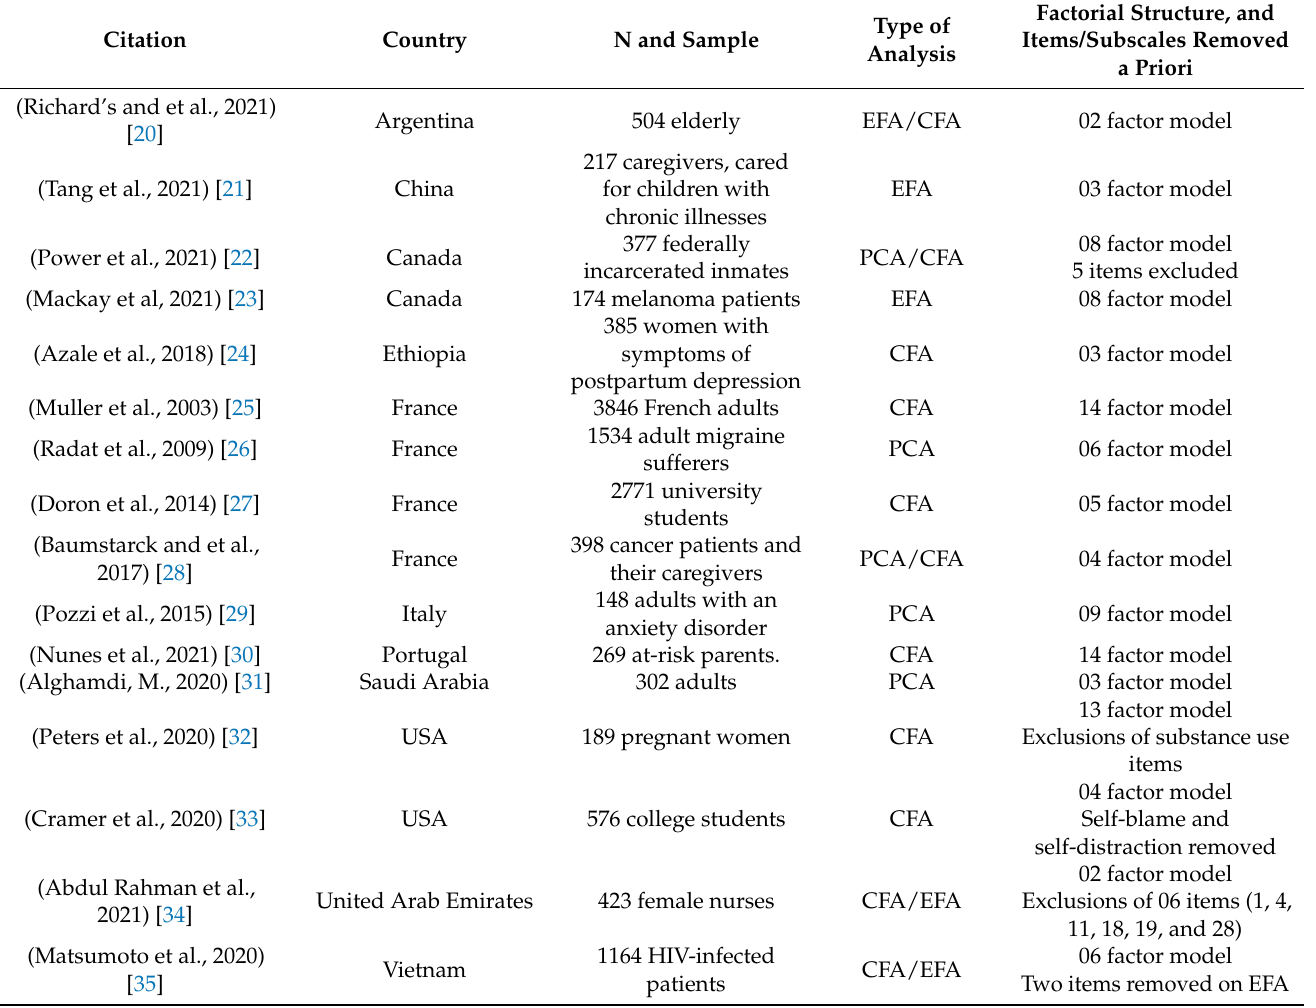
Table 1. Characteristics of the studies in the brief review on the factorial validation of the COPE